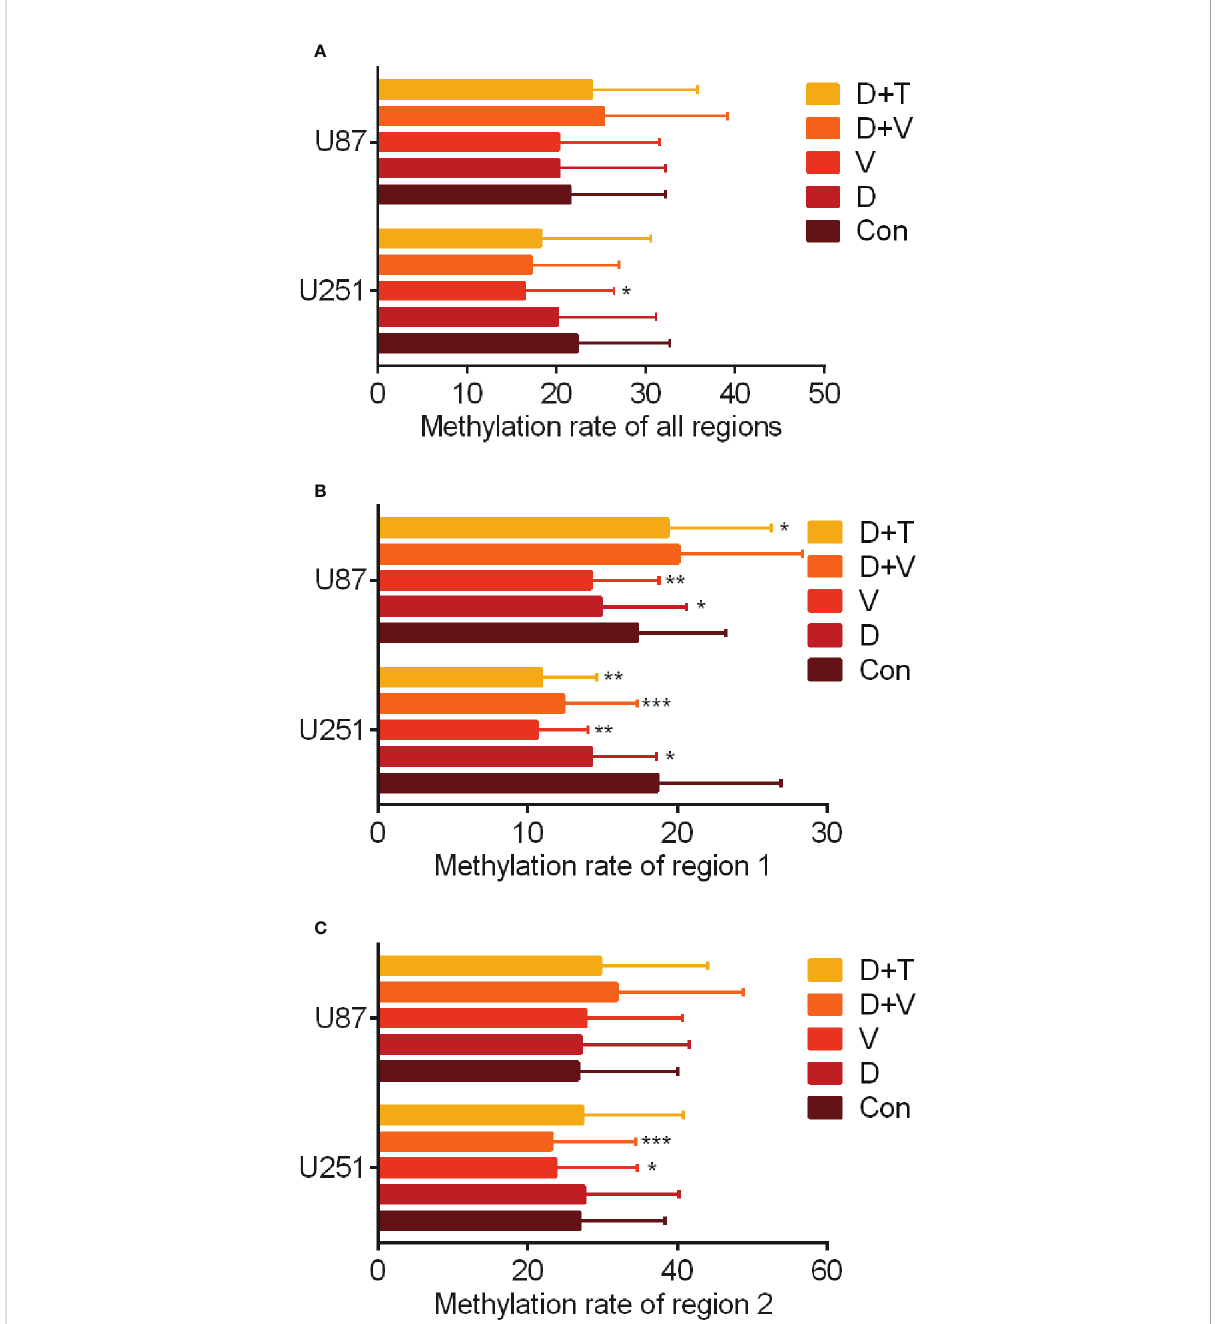
FIGURE 3 Methylation analysis of MAGE-D4 promoter region in U251 and U87 cells treated with epigenetic drugs. (A) Overall level of MAGE-D4 promoter methylation. (B) Overall level of MAGE-D4 promoter methylation in region 1. (C) Overall level of MAGE-D4 promoter methylation in region 2. Con, control; D, DAC; V, VPA; T, TSA; D + V, DAC + VPA; D + T, DAC + TSA; *P <0.05, **P <0.01, ***P